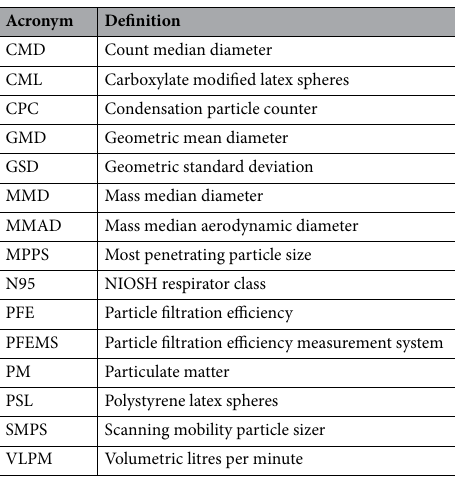
Table 1. Acronyms used commonly in this manuscript. Acronyms of organizations (ASTM, NIOSH, TSI, NRC) have been excluded.